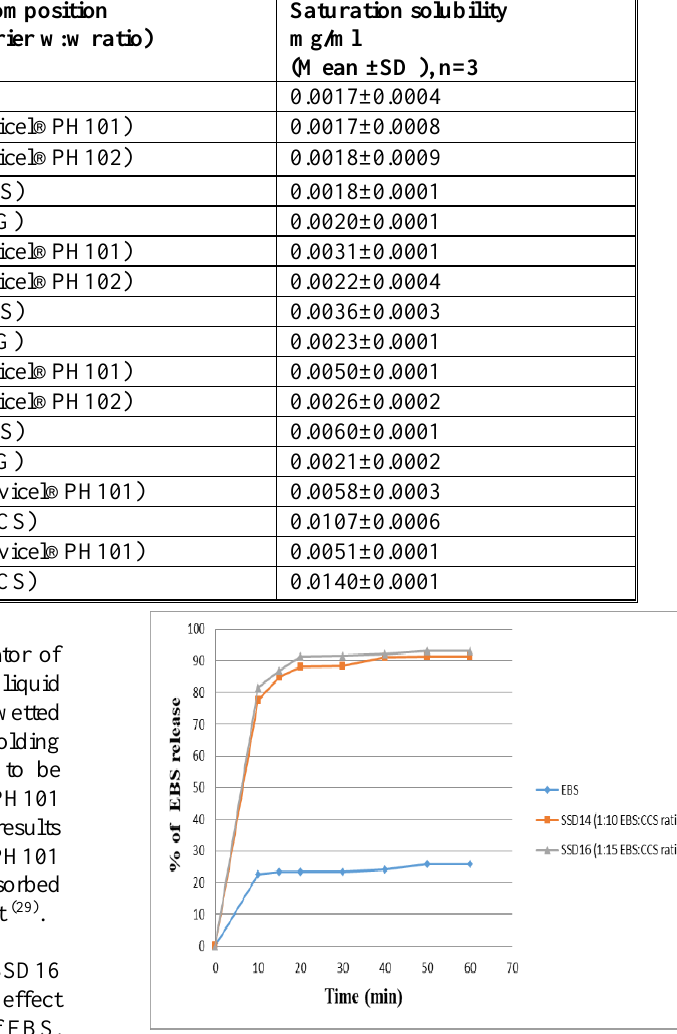
Figure 2. Effect of carrier ratio of SSD on the in- vitro dissolution of EBS in 0.1N HCl at